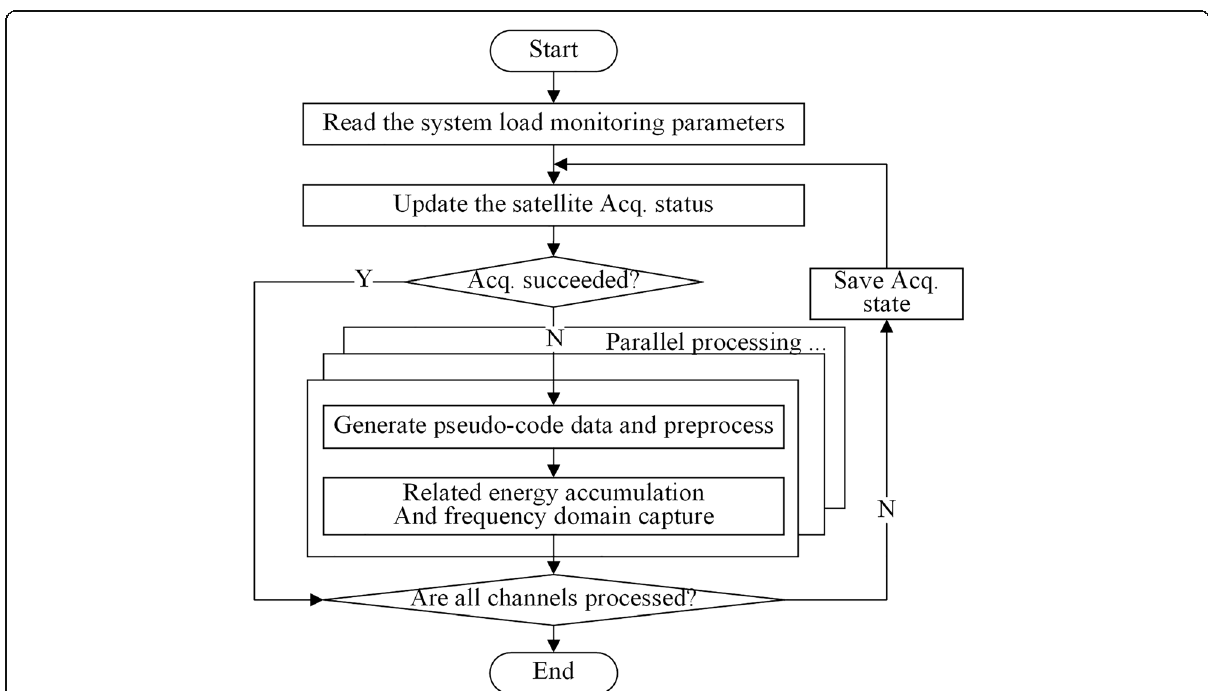
Fig. 3 Flow chart of acquisition algorithm. The figure shows a complete capture process for the multi-constellation compatibility capture strategy designed in this